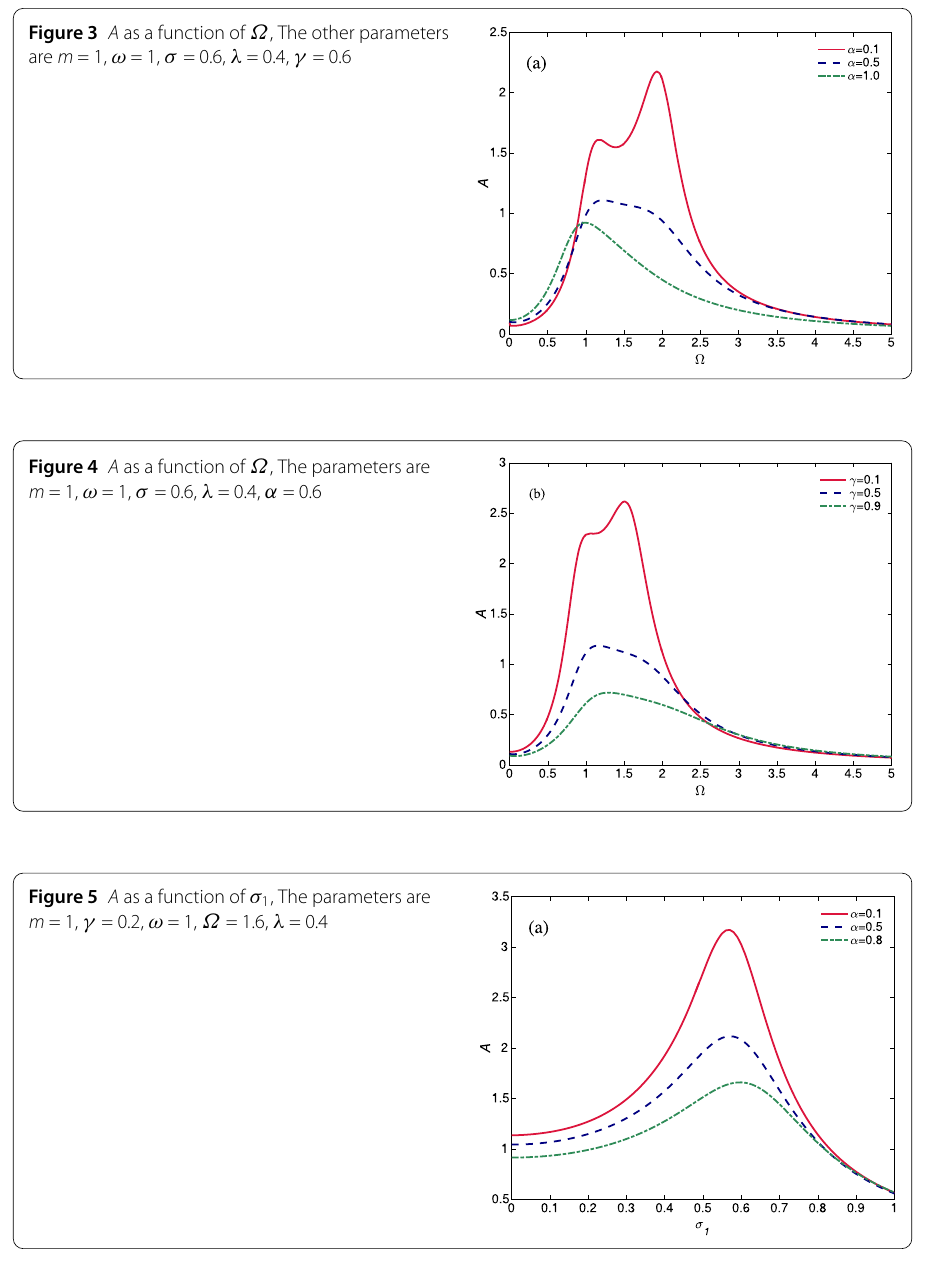
Figure 3 A as a function of Ω , The other parameters are m = 1, ω = 1, σ = 0.6, λ = 0.4, γ = 0.6